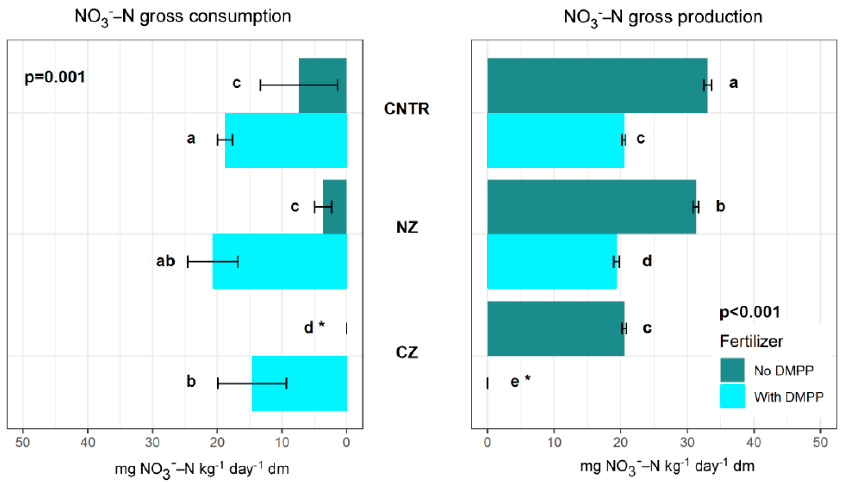
Figure 3. Gross NO 3 − -N consumption (on the left ) and gross NO 3 − -N production (on the right ) rates in treatments with and without DMPP addition. CNTR, NZ, CZ, error bars and letters as in Figure 1. “*” Due to high variability within 15 N measurements in CZ treatment, these rates resulted in slightly negative values and are hence assumed as zero. Different letters indicate significant differences between treatments as a result of ANOVA (for gross production), Kruskal-Wallis (for gross consumption) and Tukey (HSD) statistical tests ( p < 0.05).